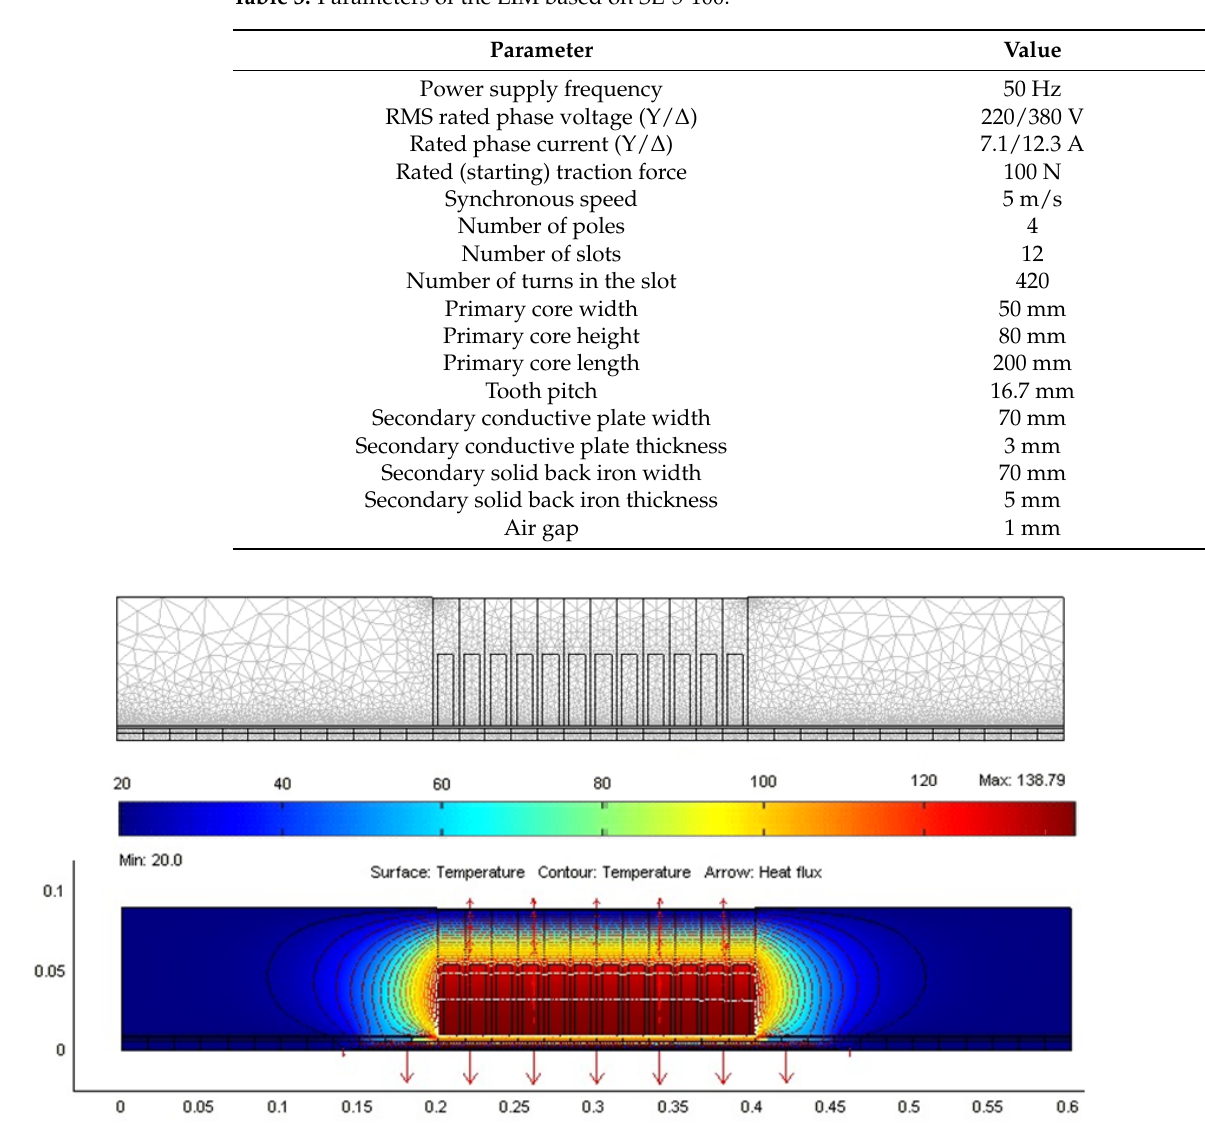
Table 3. Parameters of the LIM based on SL-5-100. Figure 6. Primary SL-5-100.